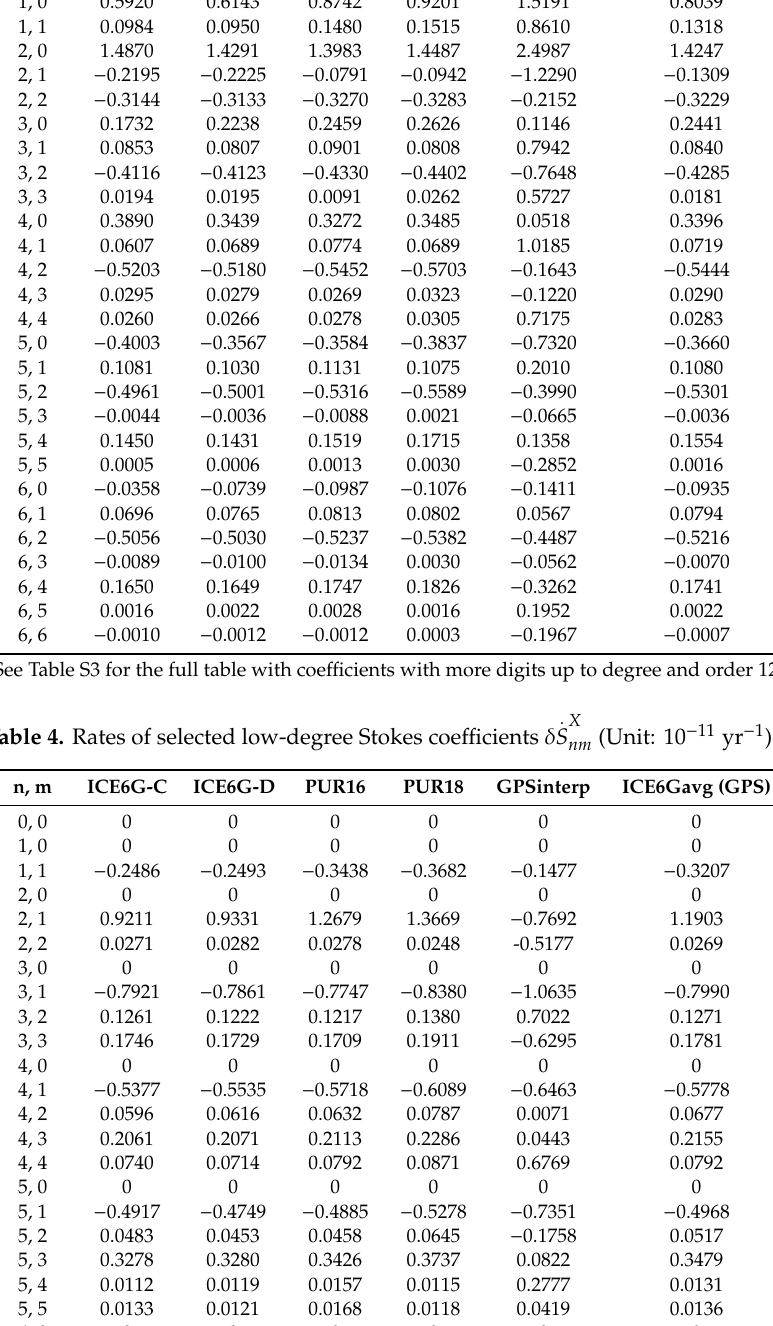
Table 3. Rates of selected low-degree Stokes coe ffi cients δ